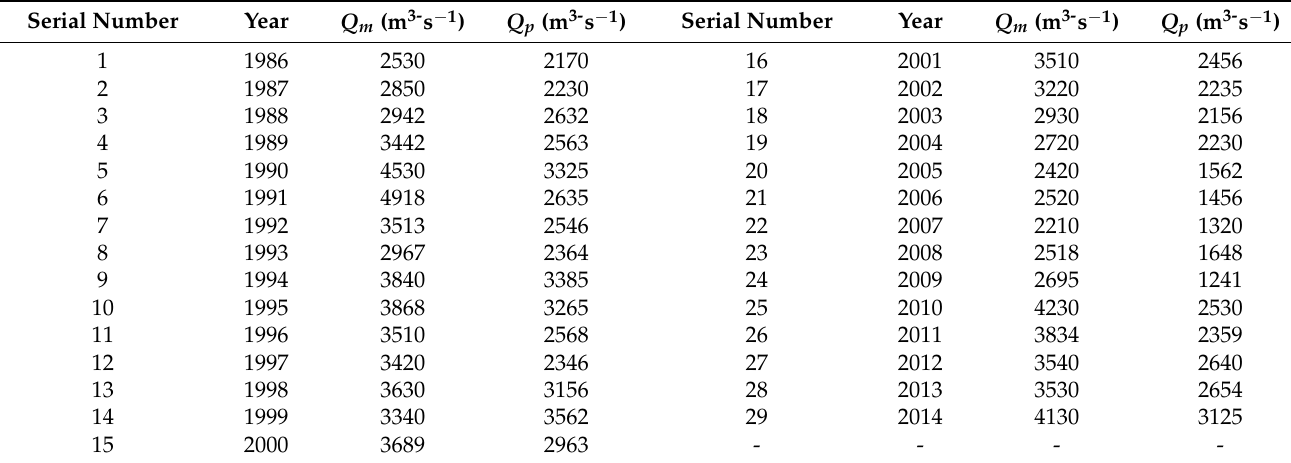
Table 1. Maximum instantaneous discharge ( Q m ) and maximum daily discharge ( Q p ) at Taunsa